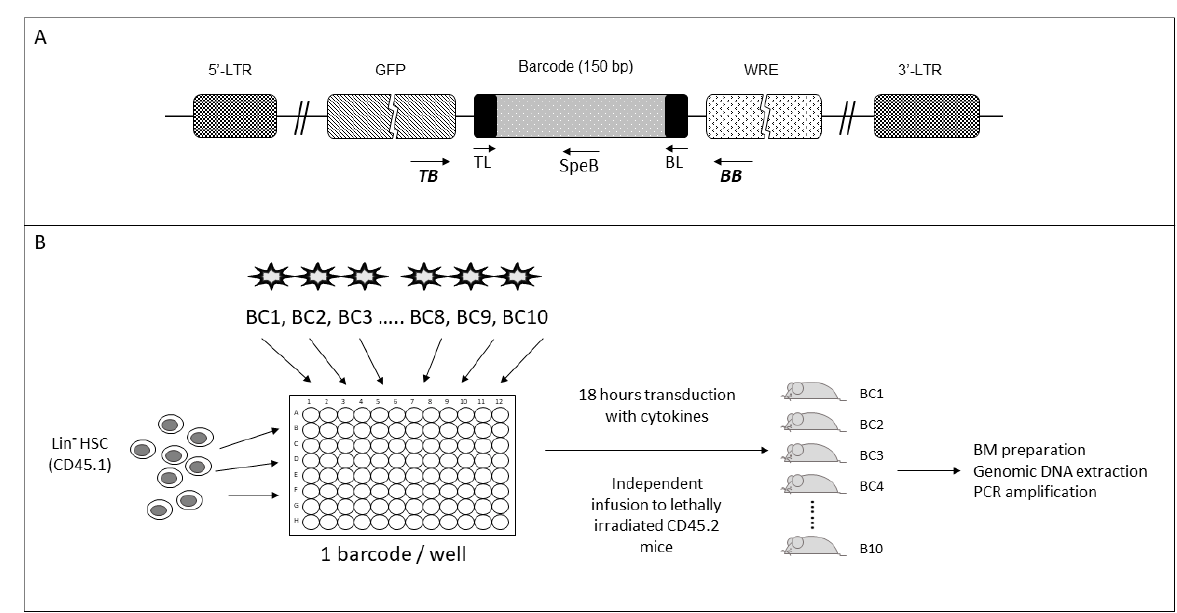
Figure 1. Schematic representation of the barcode structure ( A ) and the strategy to track barcoded cells in mice ( B ). ( A ) Diagram of the lentiviral vector carrying a 150 bp BC which is located downstream of the eGFP gene. The location of primers used to amplify all the BCs simultaneously (TL/BL or TB/BB) or each BC individually (TB/SpeB) are shown. ( B ) The BC lentiviral vector strategy used to transduce CD45.1 HSC of Lin − c-Kit + FLT3 − phenotype. One BC per well. Following 18 h, transduced cells were infused into CD45.2 myelo ablated mice, and the BCs analyzed in different tissues of transplanted mice at different times.